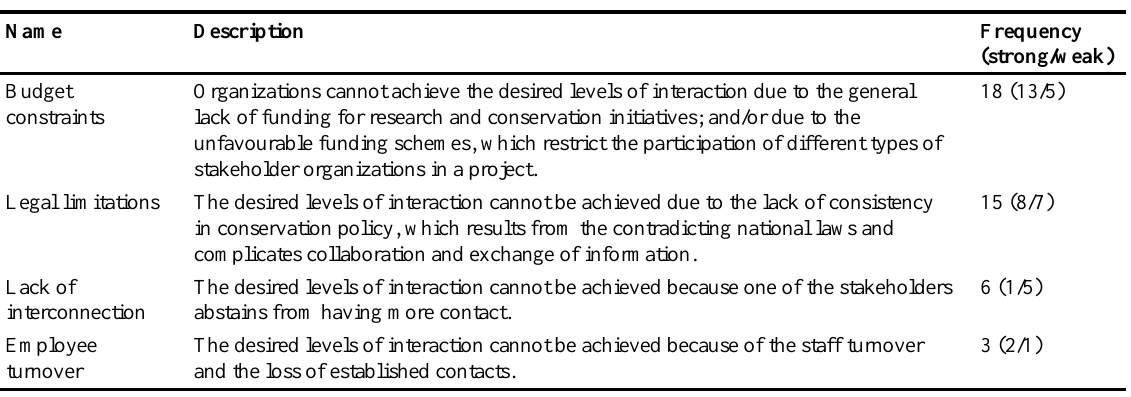
Table A2.3. Identified themes of insufficient interactions and their descriptions. ‘Frequency’ reports the number of times a theme was mentioned, with strength of representing links in